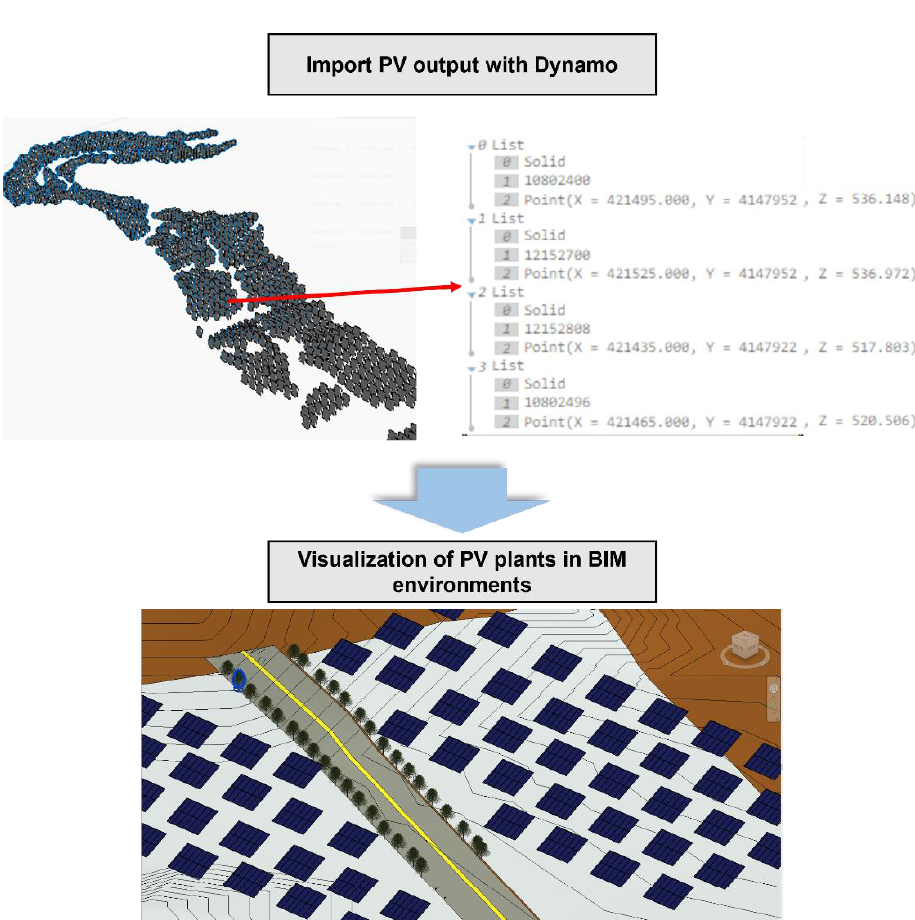
Figure 10. Visualization of a suitable solar site in the BIM environment.